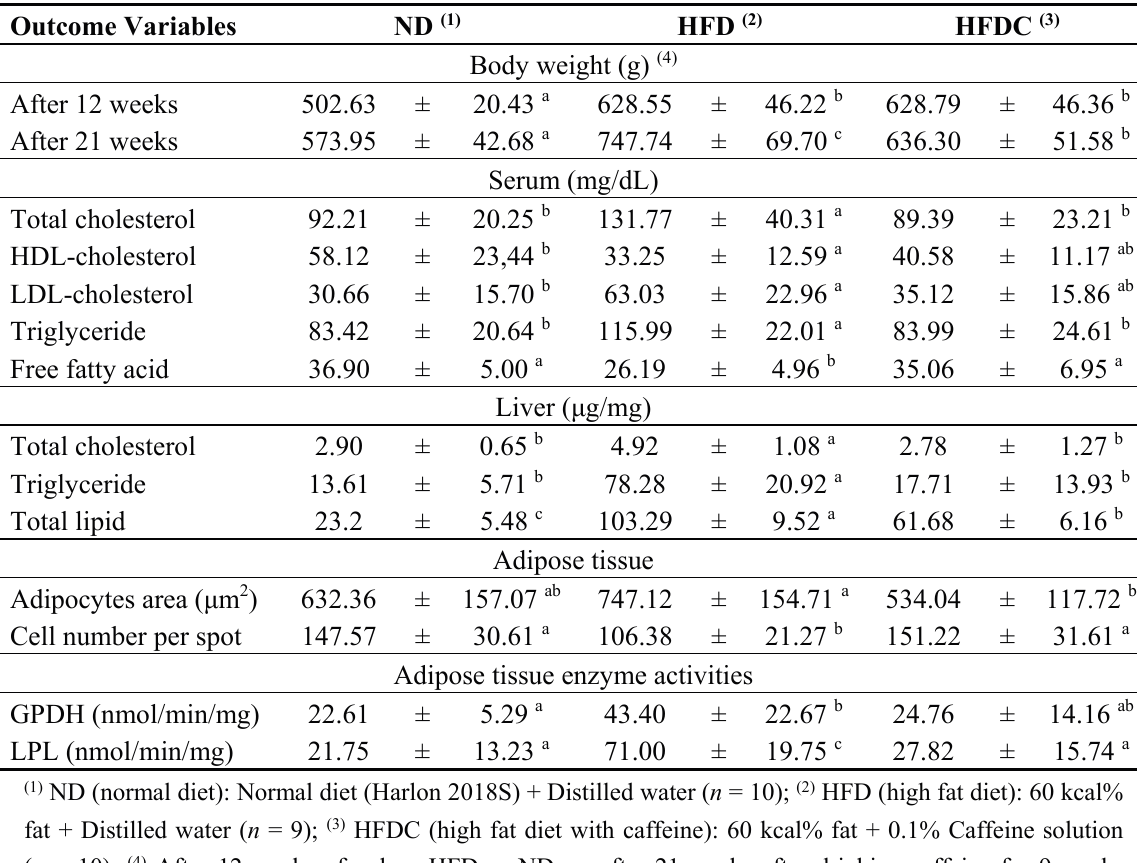
Table 1. Metabolic parameters and clinical data of rat serum, liver, and adipose tissue of different treatment